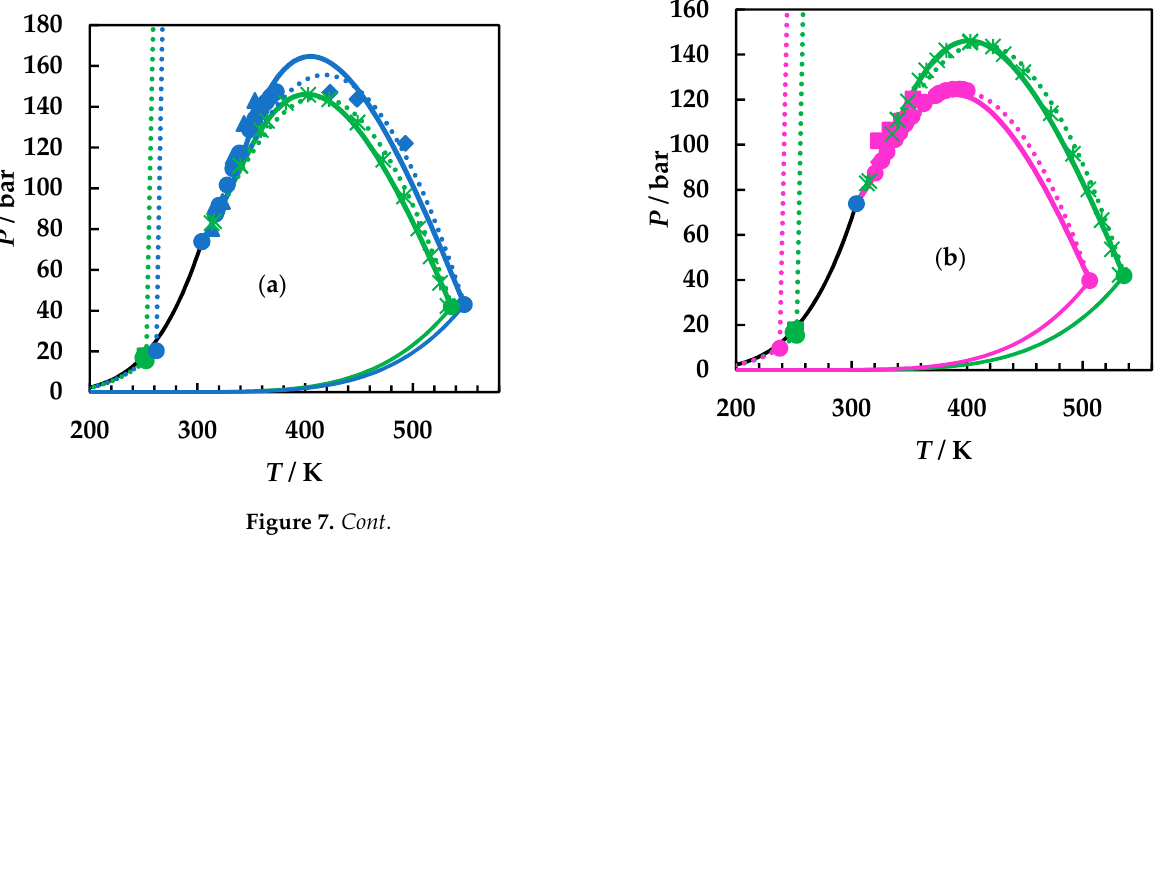
Table 7. Critical parameters ( T c , P c , V c ) and acentric factor ( ω ) for pure components.